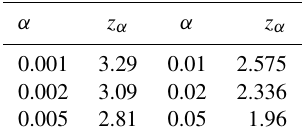
Table 1. The values of z α at different significance